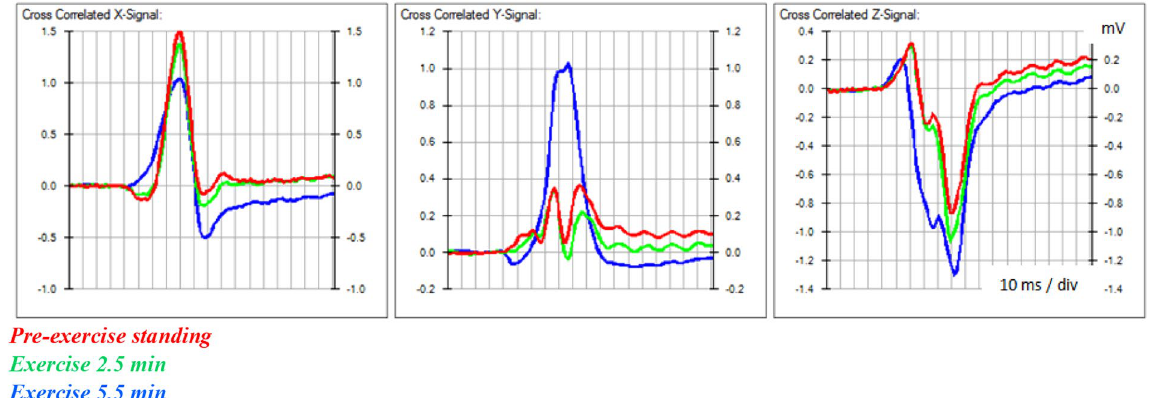
Figure 2. Alignment of QRS waveforms. The averaged QRS waveforms before and during exercise are accurately aligned for measurement of changes in the magnitude and direction of vectors derived from lead